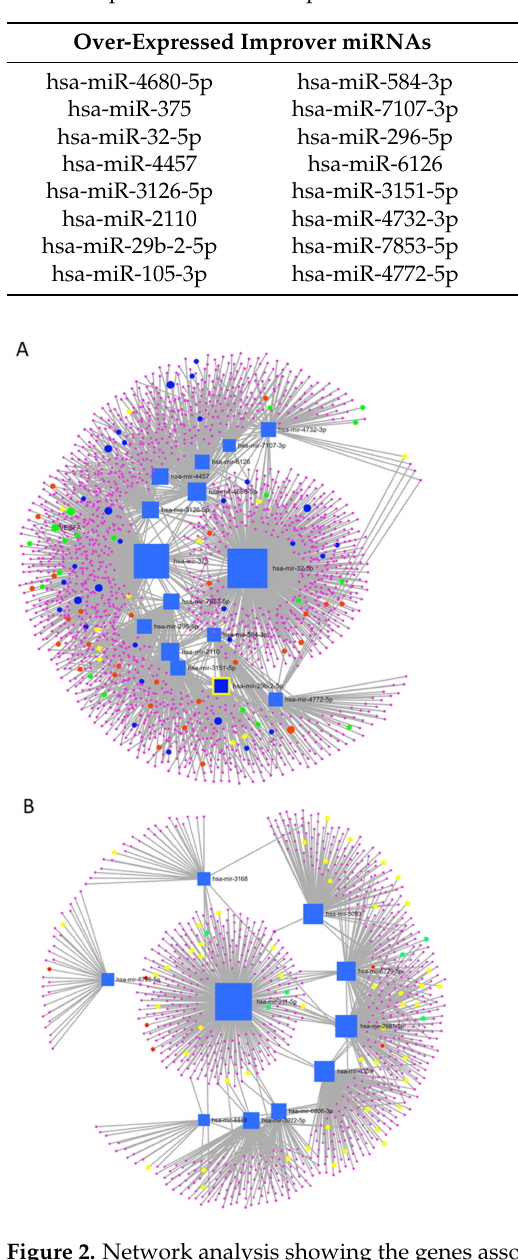
Table 4. Mining MSC-derived exosome sequencing: Differential expression of MSC cargo between clinical improvers and non-improvers.